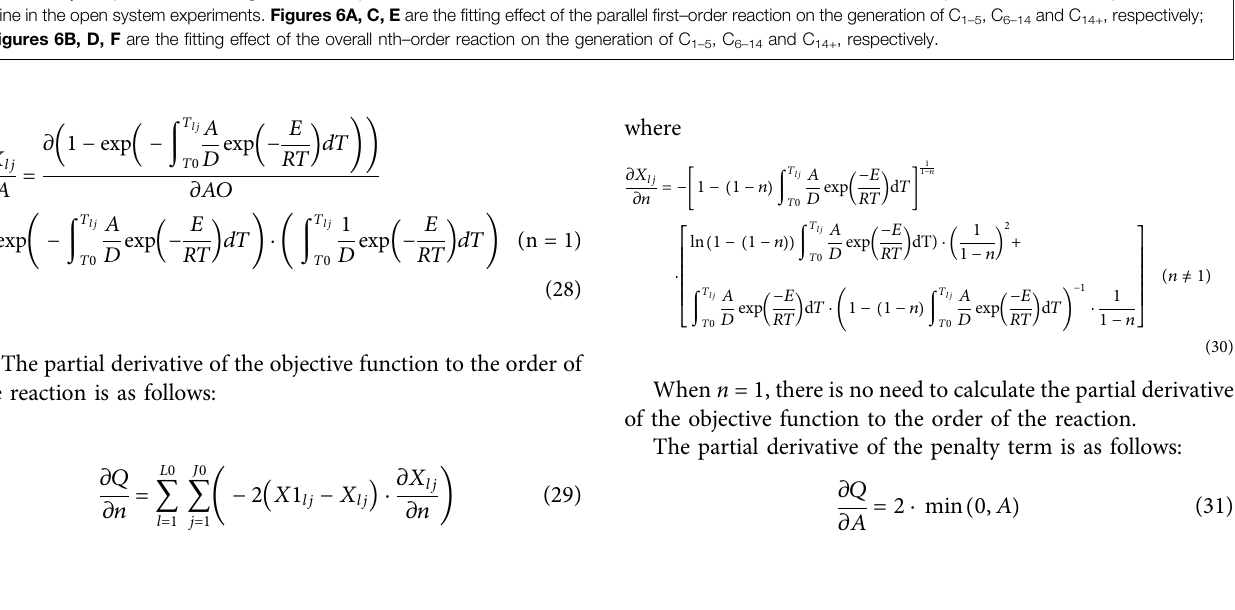
Frontiers in Earth Science |